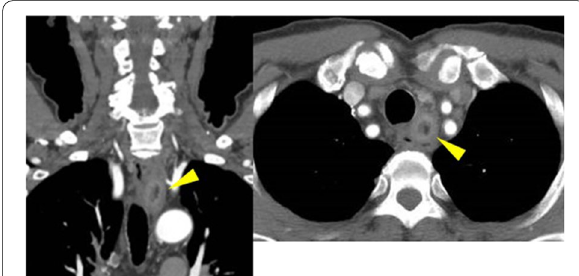
Fig. 2 Contrast-enhanced CT. A superior mediastinal foreign body, located between trachea and esophagus, was sticking toward the internal, caudal side (arrowhead)